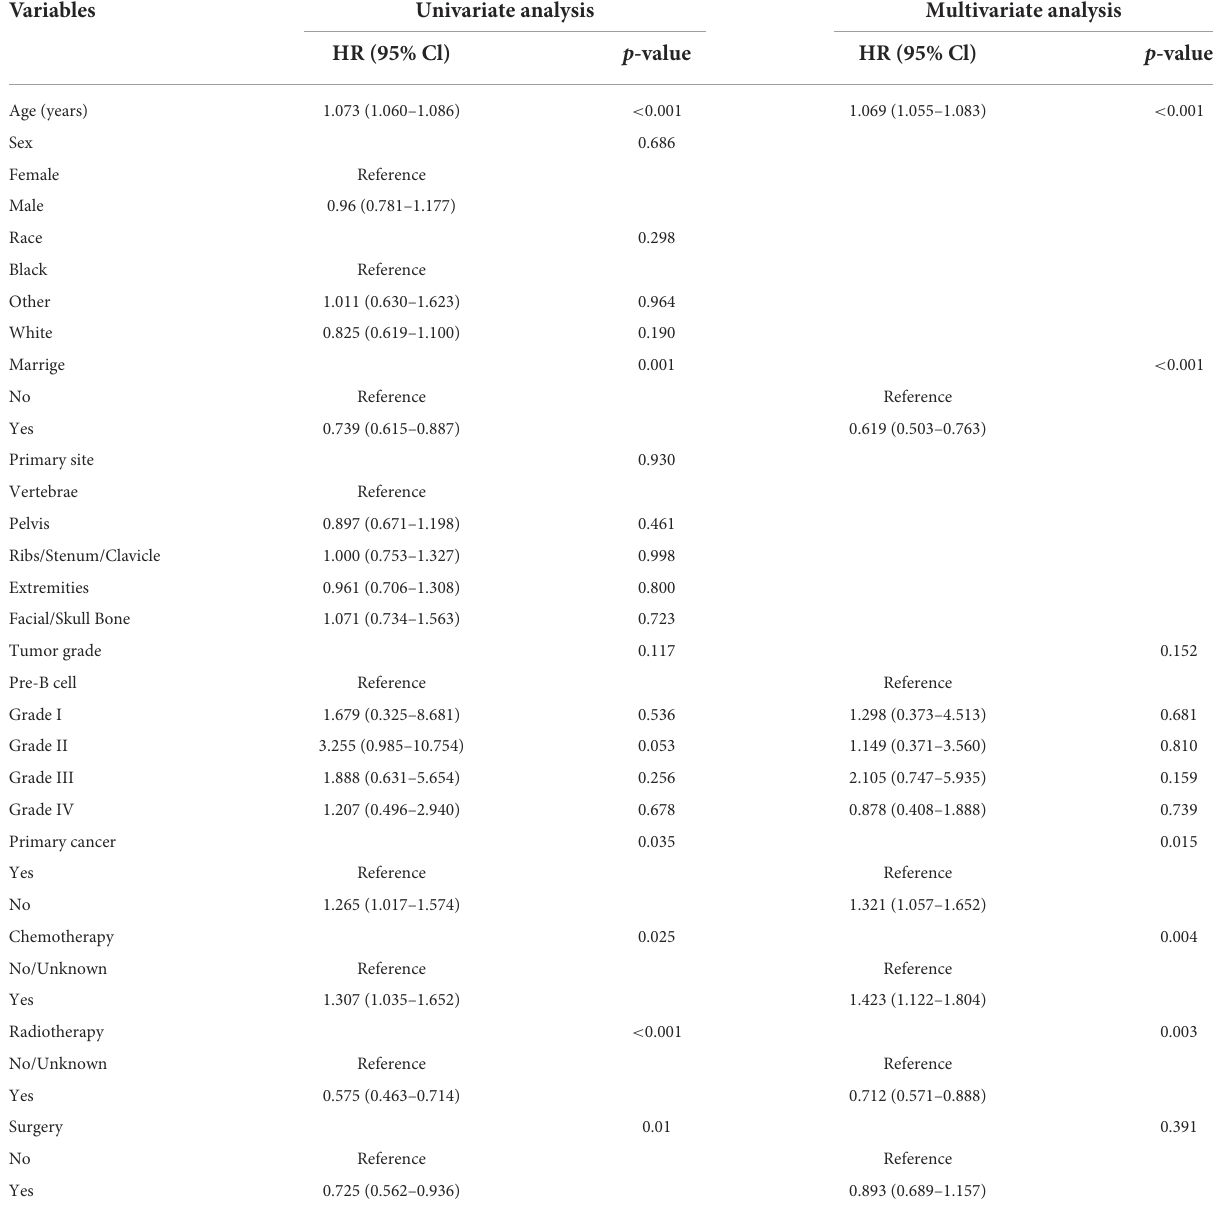
TABLE 2 Univariate and multivariate analysis of OS for SPB patients in the training set.